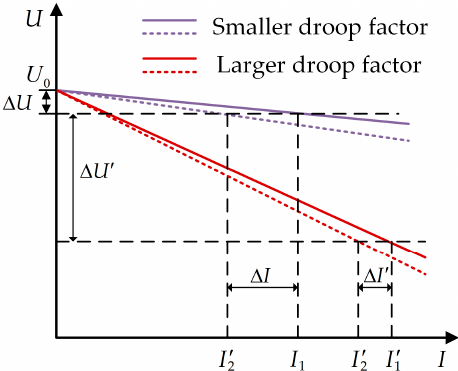
Figure 7. DC microgrid equivalent model with multiple DGs.